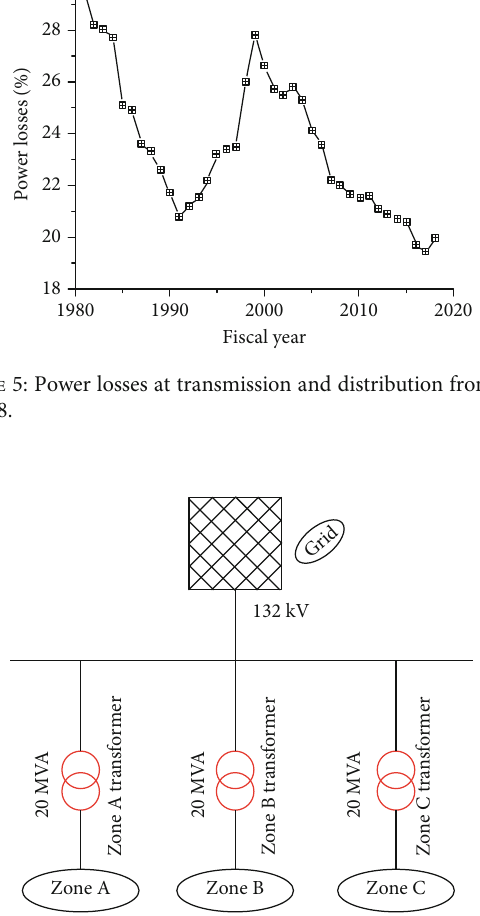
Figure 6: Simulation diagram of a 132kV grid connected to three 20 MVA